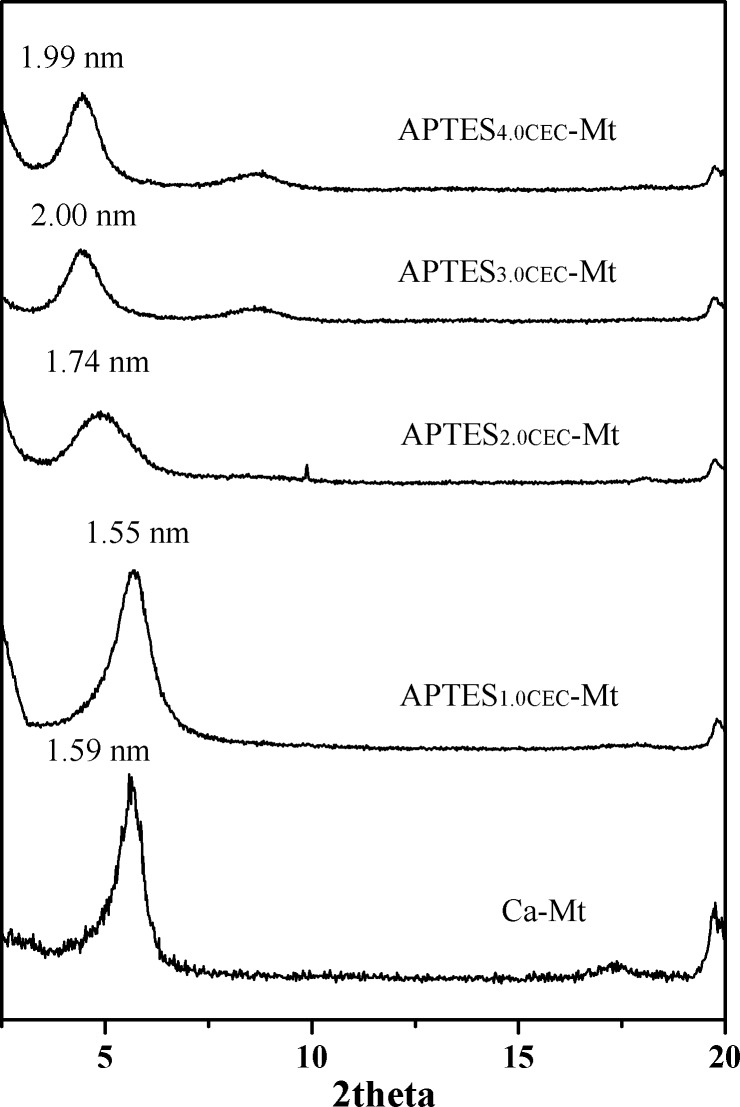
X-ray diffraction patterns of Ca-Mt, APTES1.0CEC-Mt, APTES2.0CEC-Mt, APTES3.0CEC- Mt and APTES4.0CEC-Mt.